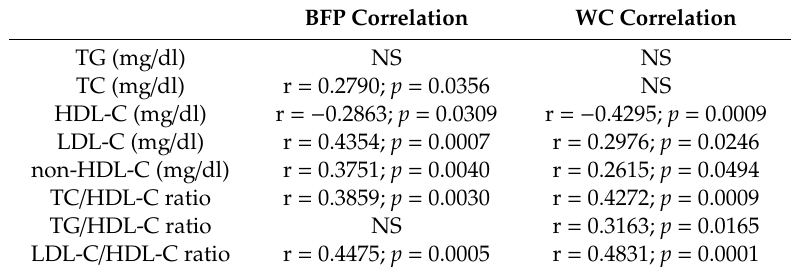
HDL-C: high-density lipoprotein cholesterol; LDL-C: low-density lipoproteins cholesterol; TC: total cholesterol; TG: triglycerides. Pearson test was performed to evaluate correlations. Statistical significance was considered when p < 0.05. NS indicates non-statistical